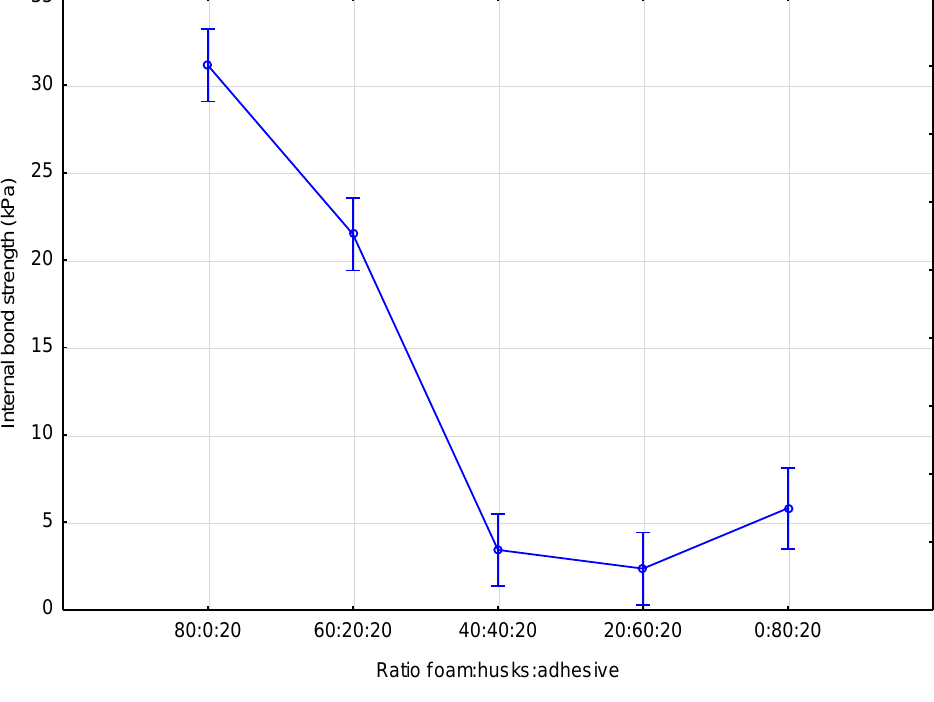
Figure 4. Impact of the composition of the panel on internal bond strength. Table 6. p-values of Tukey post-hoc test: statistical significance of the differences in the graph in Figure 4.